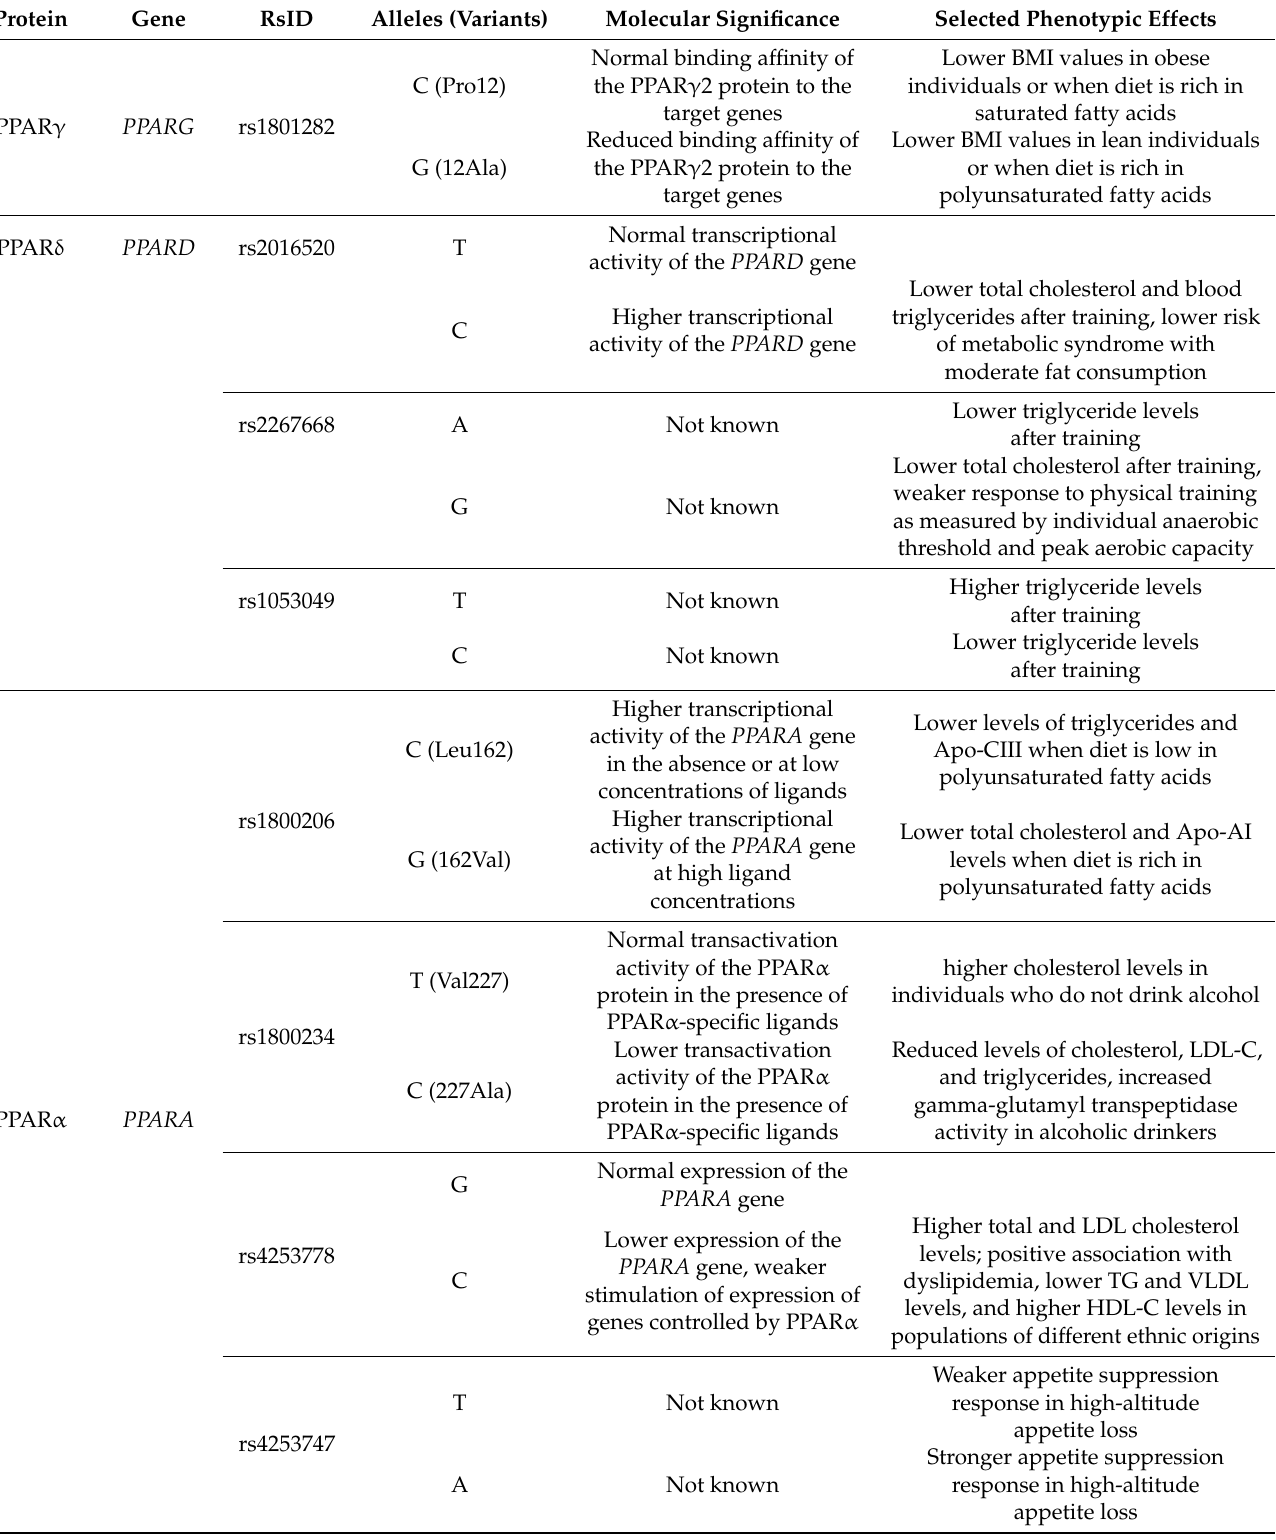
Table 1. Selected polymorphic variants of genes encoding PPAR family proteins, and their molecular significance and phenotypic effects (details in the